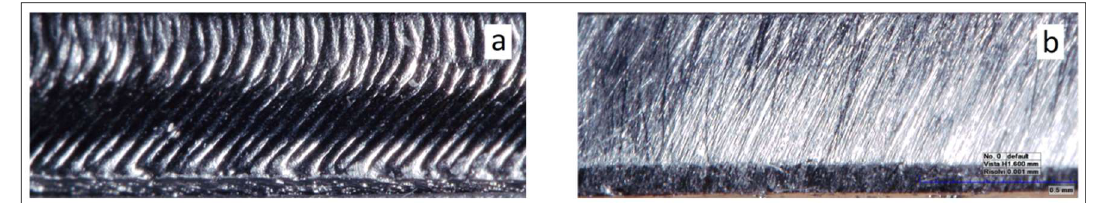
Figure 7. 3D surface reconstruction (specimens A): ( a ) Surface in the as-built condition; ( b ) Smoothed surface.